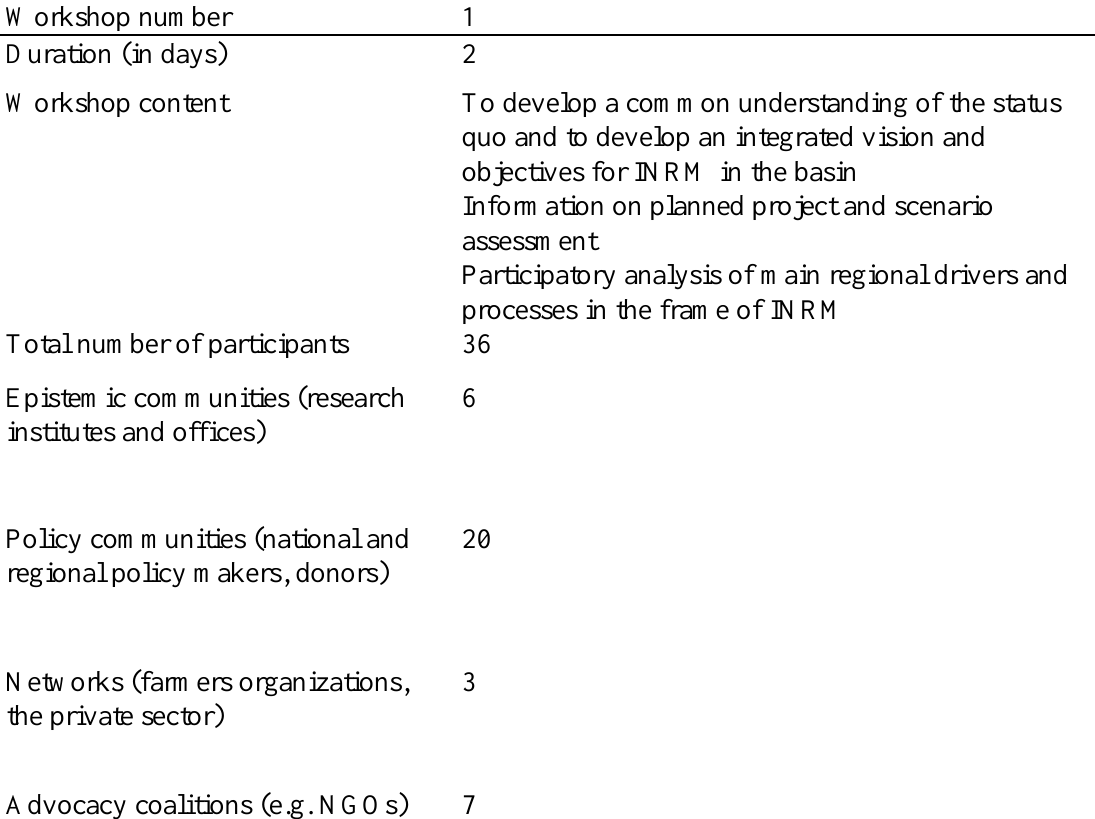
Table A1.5: Overview of the workshop undertaken for the uThukela region organised by the Institute of National Resources